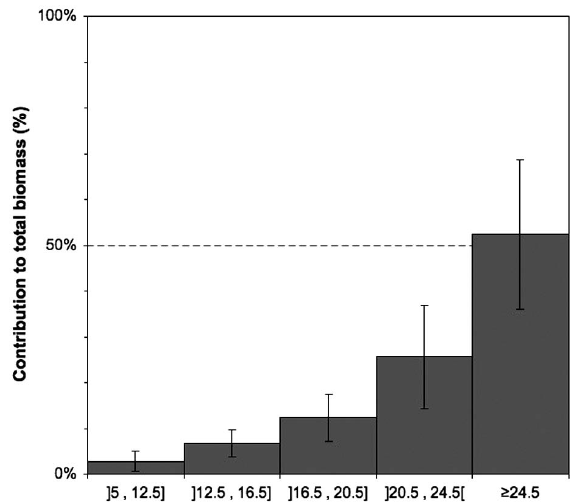
Fig . 3. – Fishery of P. pollicipes at RNB: relative contribution (mean ± SD) to total biomass (fresh weight) of each size class (RC, mm) in individual sub-sampled harvest amounts (n=10) in autumn 2005 and